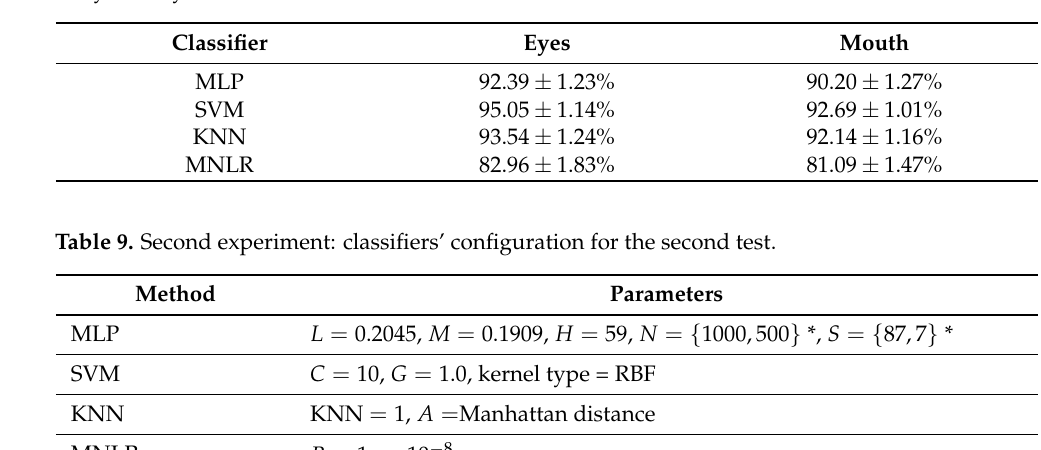
Table 8. Results on the prediction of two palsy levels on the criteria of accuracy using the 29 symmetry features.